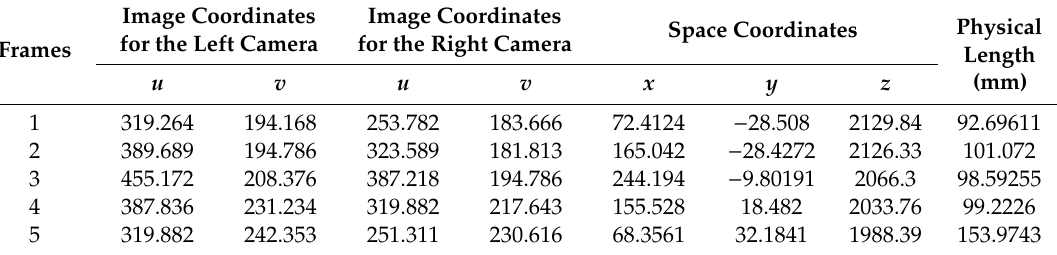
Table 4. Binocular vision measurements from group 1.